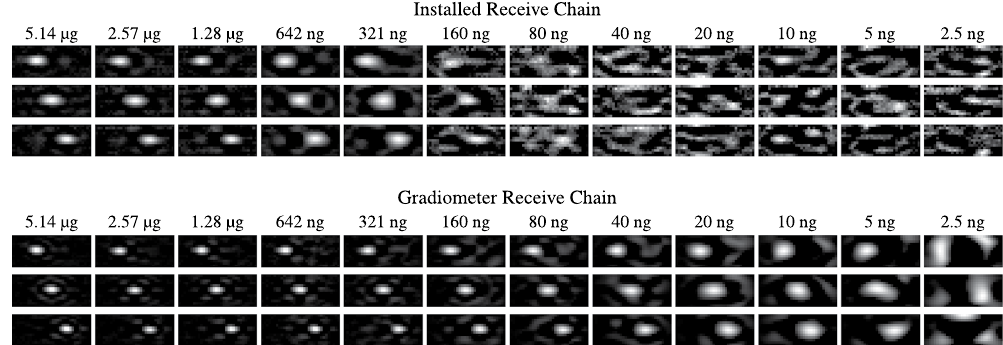
Figure 6. Reconstructed image series of the moving particle sample for the preinstalled receive chain and the gradiometer receive chain. Each image is normalized to its current maximum intensity. With decreasing iron content the reconstructed sample appears blurred which is caused by fewer frequencies involved in the reconstruction due to the adapted SNR threshold. For the preinstalled receive chain the detection limit is reached at about 160 ng iron content. For the gradiometer receive chain the detection limit is improved by a factor of 32 to 5 ng iron content. See Supplementary video S1 for an animated version of this figure.